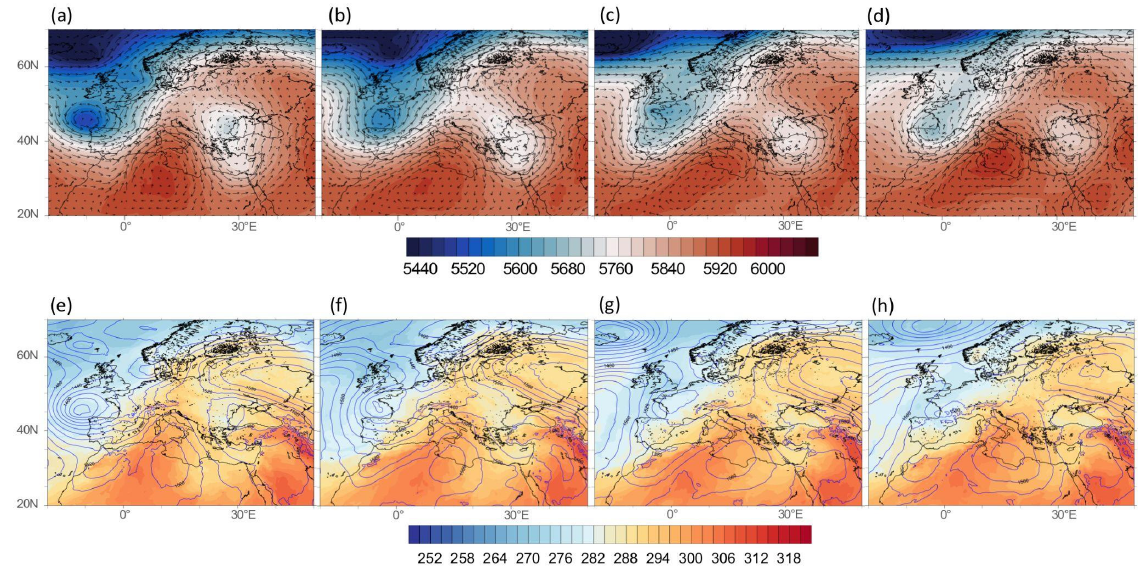
Figure 4. Upper panels: NCEP-FNL geopotential height (m) and wind vectors at 500 hPa; bottom panels: NCEP-FNL temperature (K; colors) and geopotential height (m; contours) at 850 hPa. The panels refer to 20 ( a , e ), 21 ( b , f ), 22 ( c , g ) and 23 ( d , h ) June at 12:00 UTC.